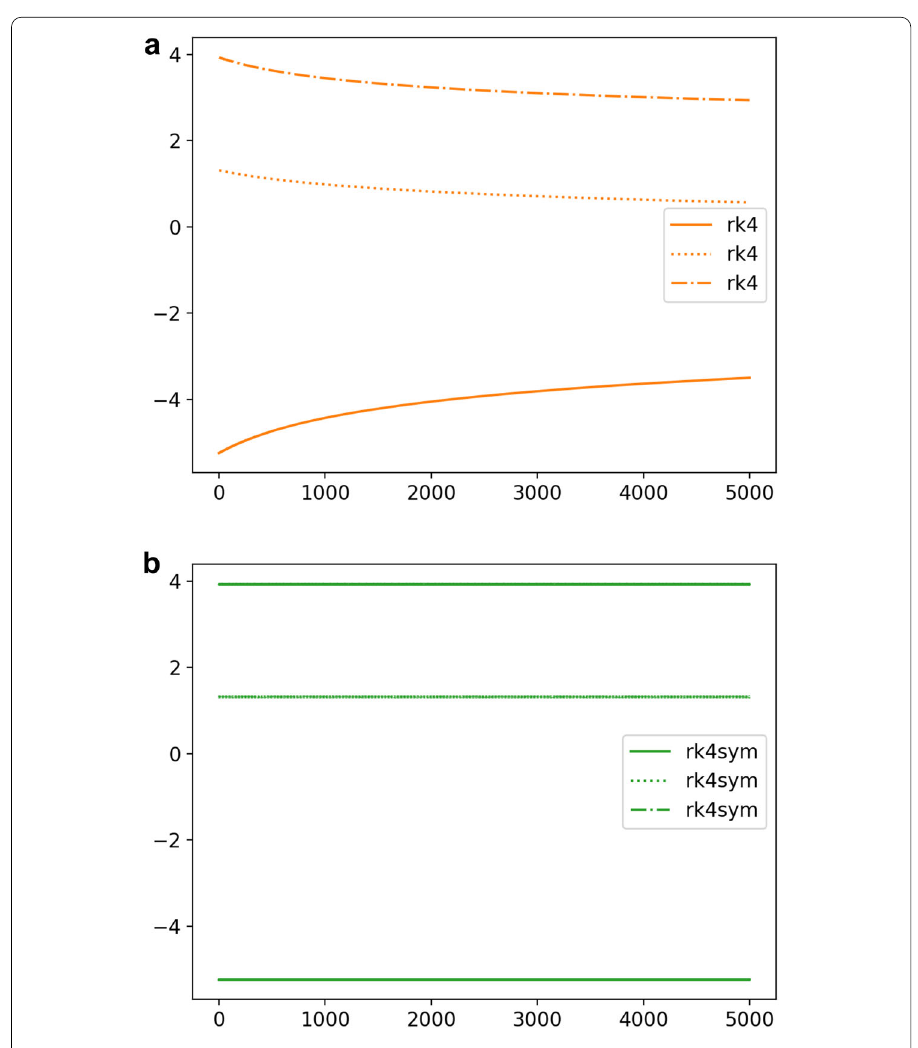
Fig. 4 Toda lattice. Evolution of the eigenvalues of L with (cid:5) t = 10 − 1 . a RK4. b